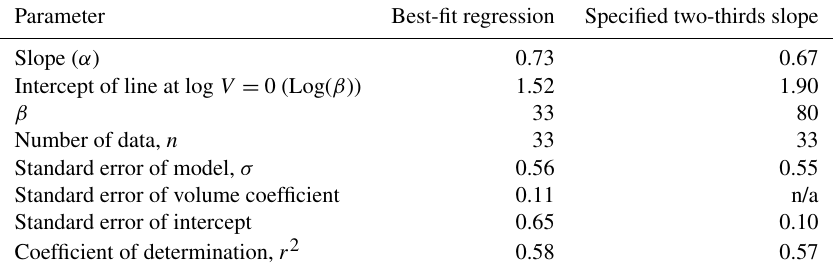
Table 4. Statistical results of the regression analysis for the best-fit and specified two-thirds slope models. n/a stands for not applicable.